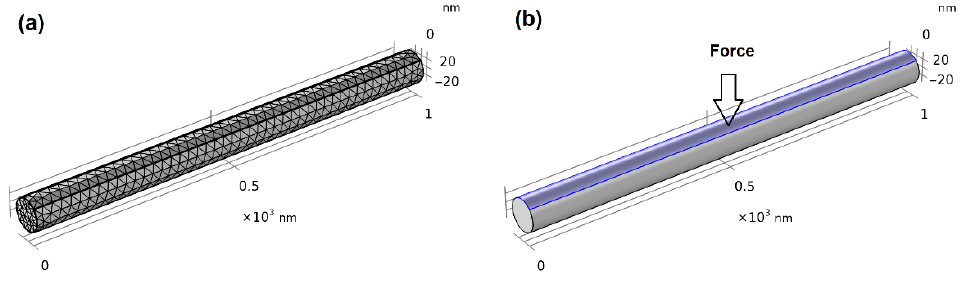
Figure 1. ( a ) Finite elements in a cylinder with length of 1000 nm and diameter of 75 nm; ( b ) direction of applied